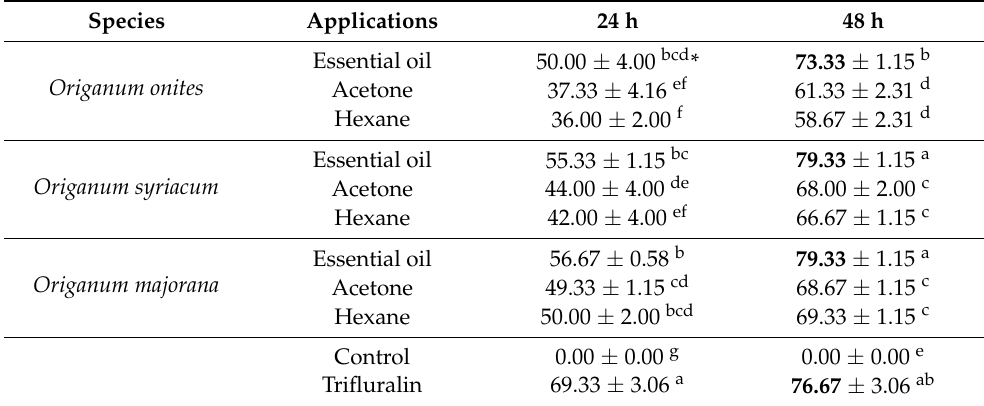
Table 3. The mortality rate (%) of Amaranthus retroflexus in nursery.